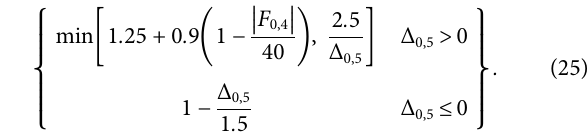
Frontiers in Built Environment |